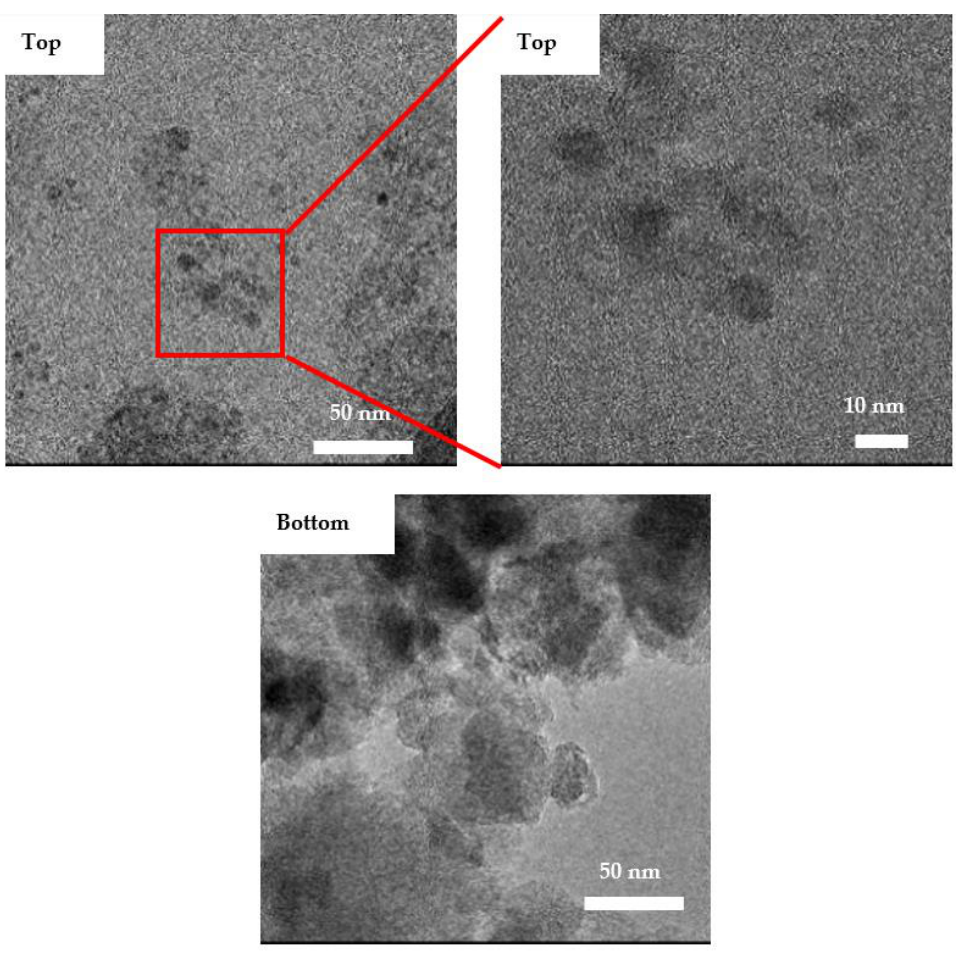
Figure 9. TEM images of the top and bottom products of the ball-milled samples.